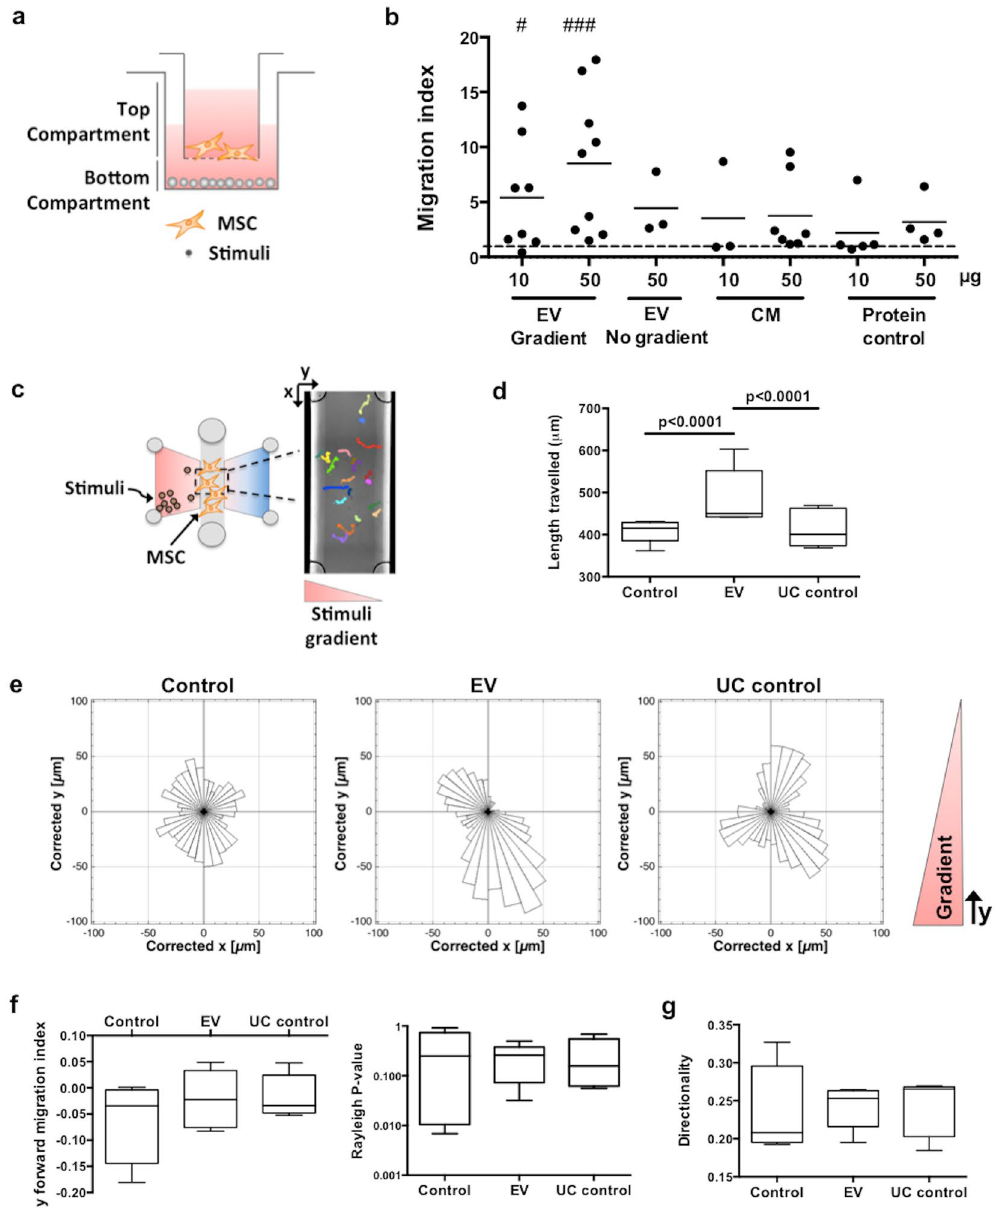
Figure 4. DC-derived EV specifically promote MSC migration. ( a ) Representation of the transwell system set up for MSC recruitment assay. EV or control stimuli were added to the bottom compartment, acting as chemoattractants for MSC seeded inside the gelatin-coated transwell insert. For gradient disruption, 50 μ g EV were diluted in media that was then equally distributed in the top and bottom compartments (no gradient). ( b ) MSC were allowed to migrate for 8 h, and then stained with DAPI. Total number of migrated cells adhered to the outer surface of the insert membrane were counted and migration index calculated to non-stimulated control. The dashed line represents the migration index of non-stimulated control. Each dot represents an independent experiment (n = 3 to 9 DC donors) and the mean value of cells migrated is indicated as a dash. For statistical analysis Kruskal-Wallis test, followed by uncorrected Dunn’s multiple comparison test was used, # P = 0.0152 and ### P = 0.0002, compared to non-stimulated control. ( c ) Representation of the chamber setup for MSC chemotaxis assay. Stimuli were added on the left side of the chamber and a gradient was formed across the central channel, where MSC were seeded (n = 5 DC donors). For each condition, MSC were followed for 13 h by time-lapse video microscopy, and cell pathways were then determined by manual tracking, as represented by the coloured tracks overlay on the exemplificative central channel image. See also Supplementary Fig. S1. ( d ) Box plots represent total length of the pathways travelled by MSC. Statistical analysis used 2-way ANOVA, followed by uncorrected Fisher’s multiple comparison test, p values are indicated. ( e ) Representative rose diagram of MSC direction of migration (x and y position normalized for cell’s initial position). ( f ) MSC forward migration index in gradient y-direction (left panel), and p-value of cell direction uniformity as determined by Rayleigh test (right panel). ( g ) Directionality of MSC migration. All box plots are min to max, with median value